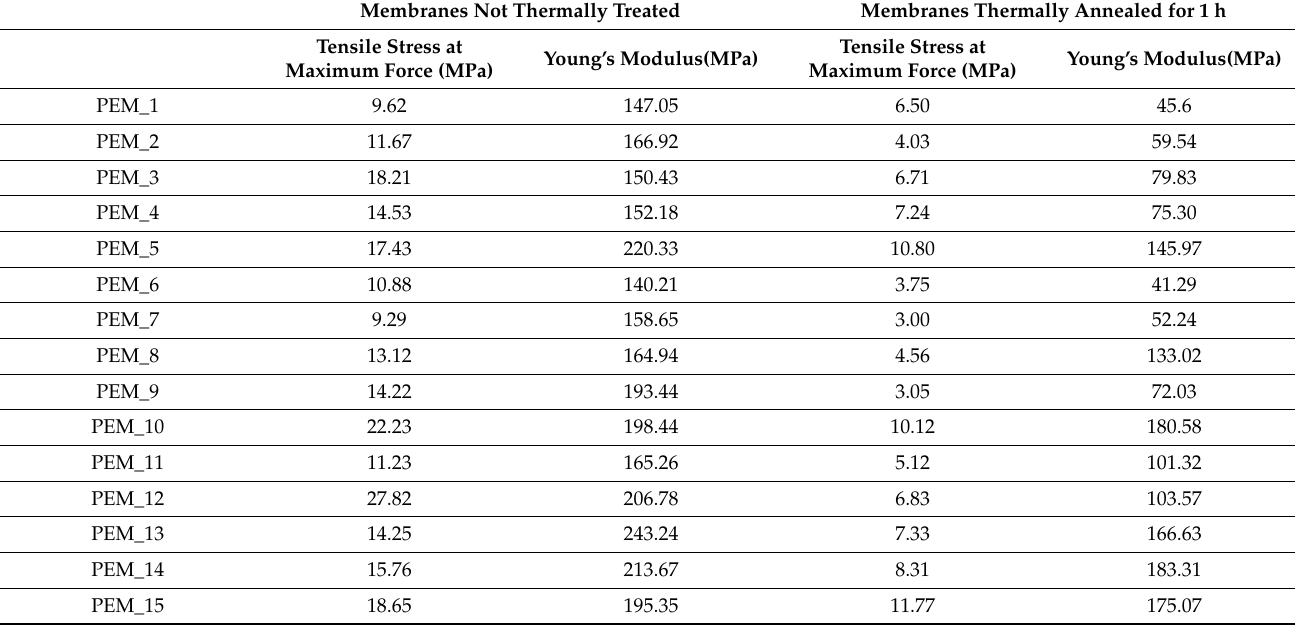
Table 7. Tensile stress at maximum force and Young’s modulus for all synthesized SBC membranes.